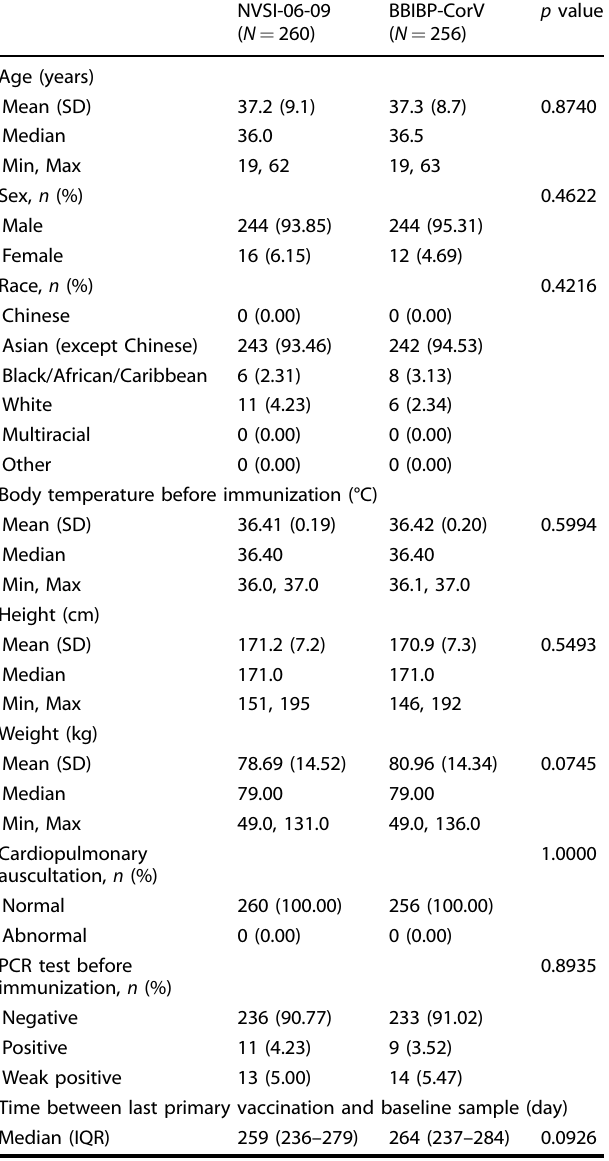
Table 1. Demographic characteristics of the participants (FAS)